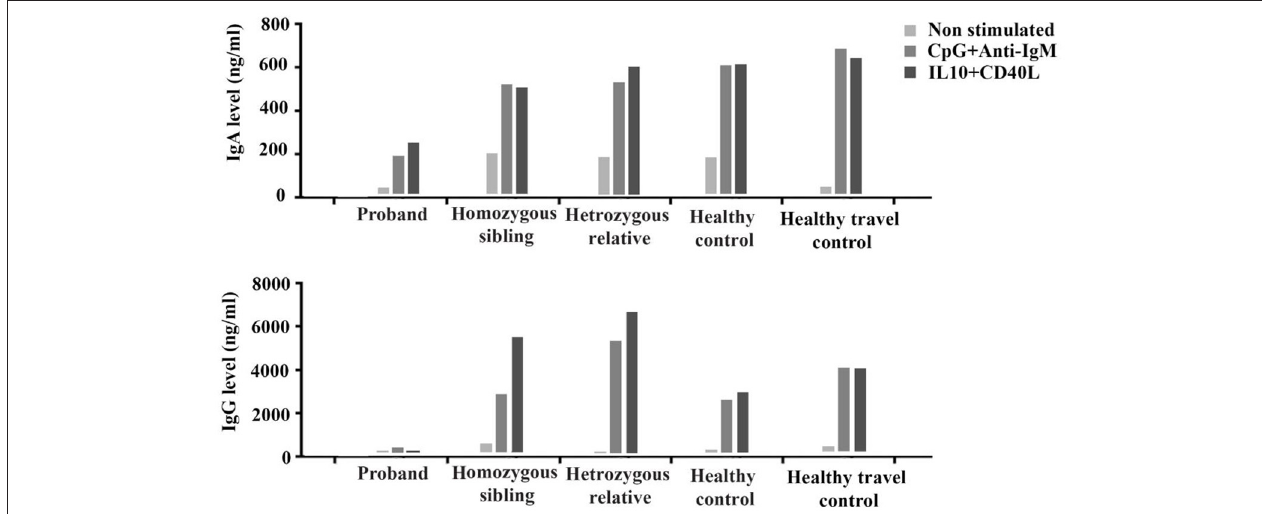
FIGURE 1 | In vitro production of IgA and IgG before (non-stimulated) and after stimulation with T-independent (CpG + anti-IgM) and T-dependent (IL-10 + CD40L) cytokines in the proband, the homozygous sibling, a heterozygous relative, and two healthy controls.